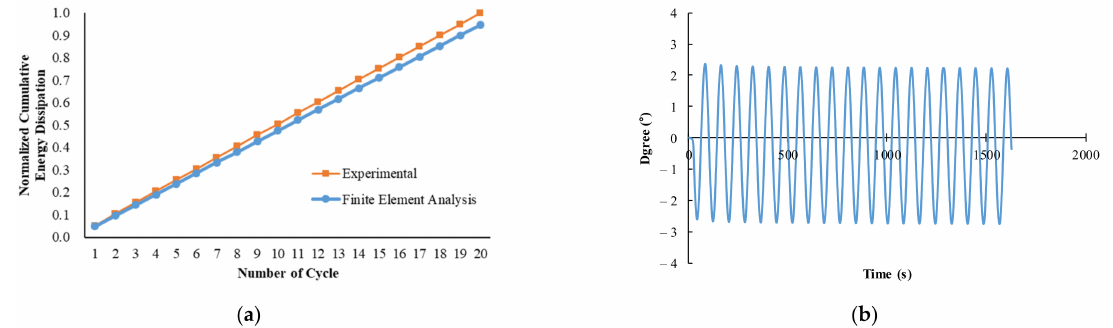
Figure 6. Energy and deformation angle change of the elbow system: ( a ) normalized energy dissipa- tion; ( b ) deformation